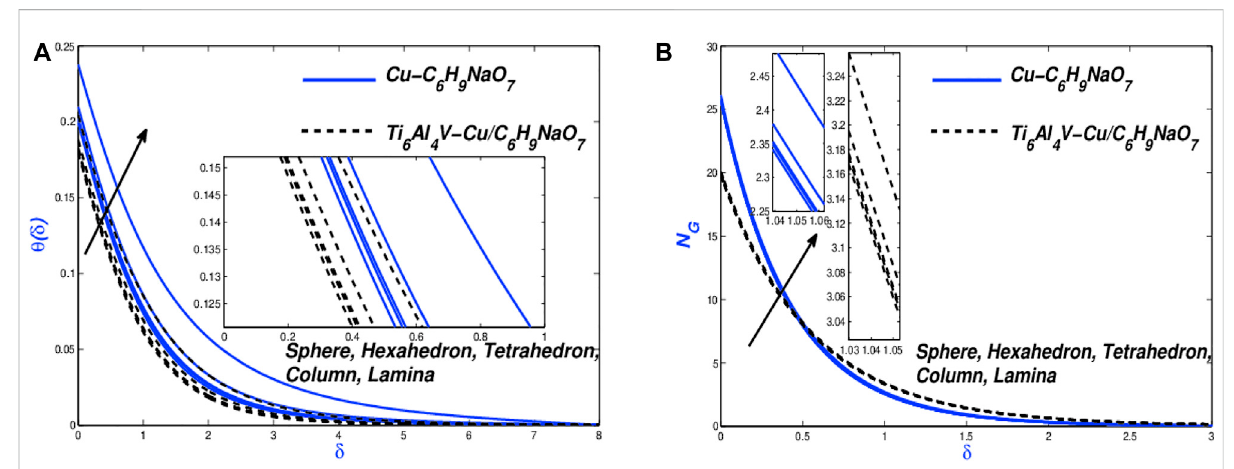
FIGURE 7 (A) θ ( δ ) and (B) N G with diverse m